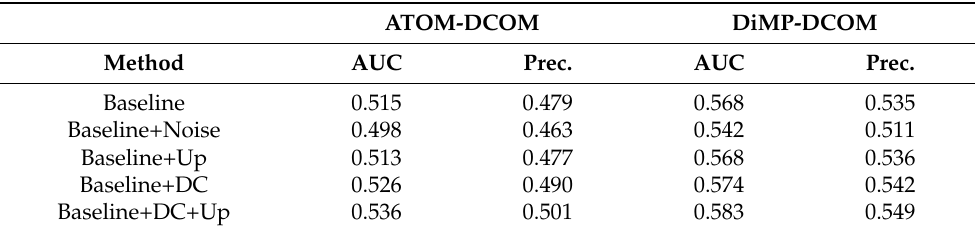
Table 3. Ablation study of the sub-modules on